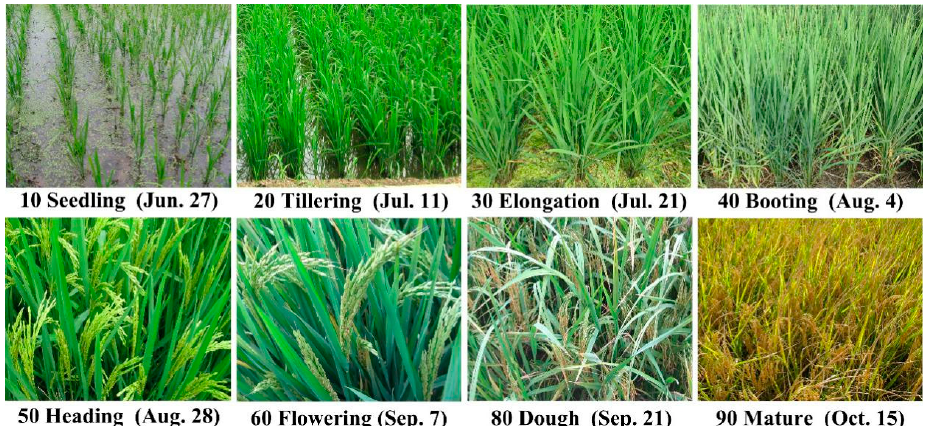
Figure 2. The rice morphologies at different phenological stages are shown along with the SAR image acquisition dates. The phenological stages are quantified using the BBCH scale.